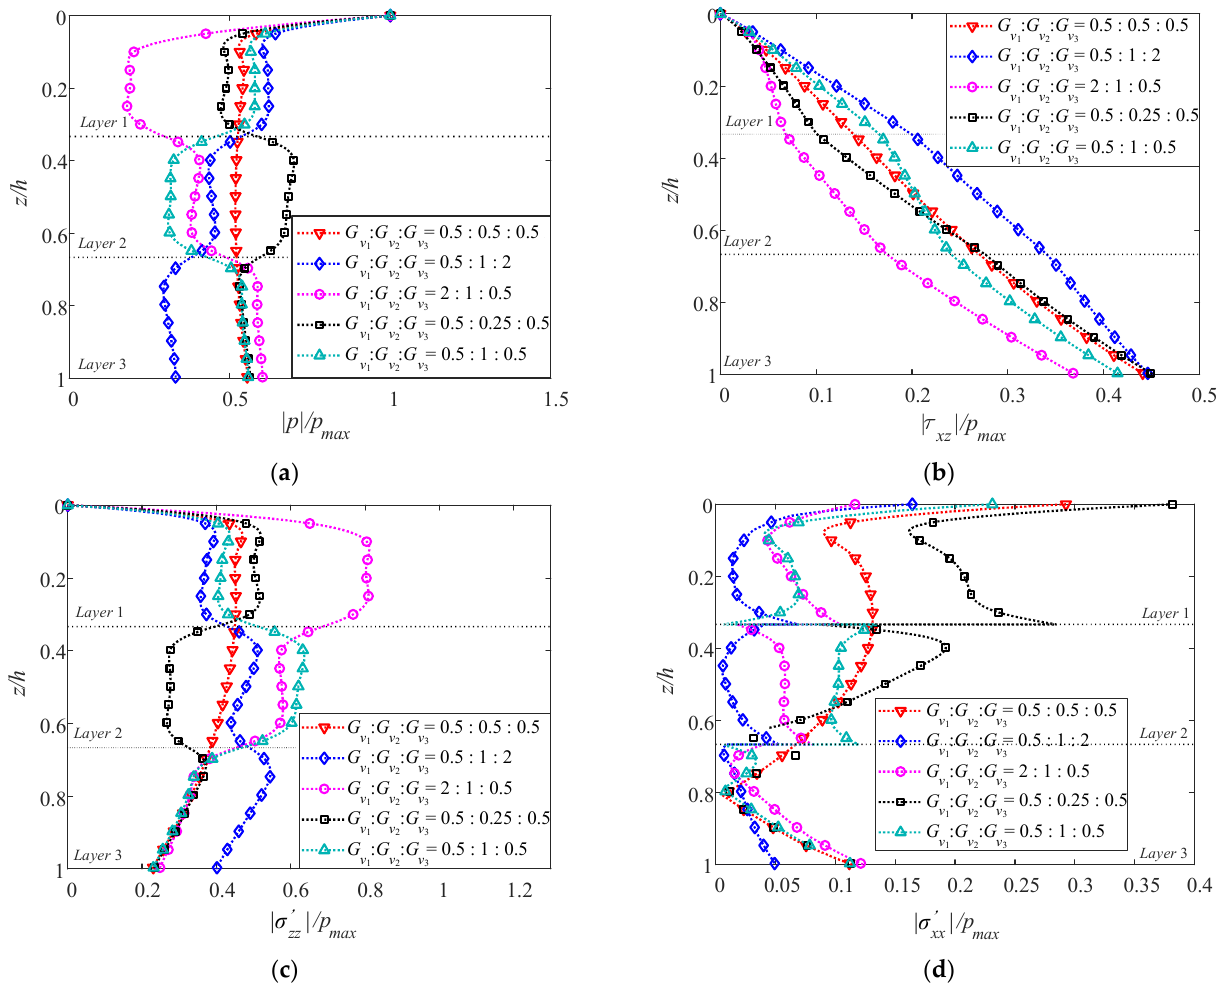
Figure 19. Vertical distributions of normalized maximum ( a ) pore pressure, ( b ) shear stress, ( c ) vertical effective stress, and ( d ) horizontal effective stress by varying G v 1 : G v 2 : G v 3. The distributions of liquefaction depth by varying G v 1 : G v 2 : G v 3 with G vo / E vo ( o = 1, 2, 3), respectively, equal to 0.5, 1/2.6 and 0.1, are presented in Figure 20a–c. When the ratio G v 1 : G v 2 : G v 3 is fixed, z max increases as G vo / E vo ( o = 1, 2, 3) decreases. Especially for case 2, compare Figure 20b,c, z max with G vo / E vo = 0.1 ( o = 1, 2, 3) is triple that with G vo / E vo = 1/2.6. Therefore, it is essential to consider the transverse isotropy of soil when G v / E v < 2(1+ v ), otherwise the maximum liquefaction depth would be underestimated. With declining G vo / E vo ( o = 1, 2, 3), z max of cases 1, 2, 4, and 5, where the top layer’s soil properties are identical, become close to each other. Hence, the influence of the G v of multilayers decreases gradually along with the depth.